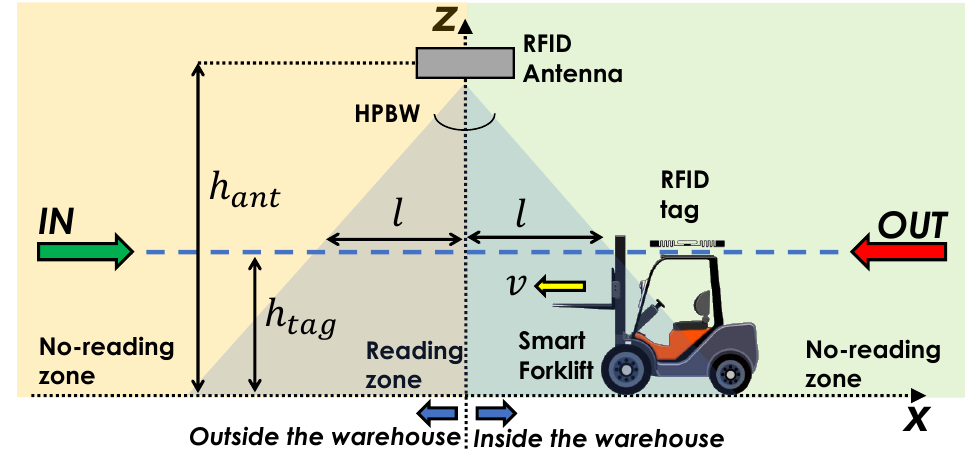
Figure 8. Sketch of the symmetrical configuration of the RFID Smart